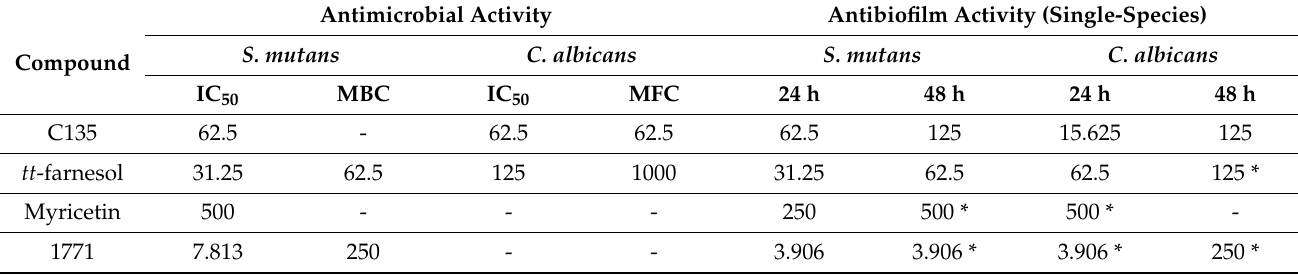
* represent selected concentrations that did not reduce 50% of CFU/mL but had a significative statistical reduction vs. vehicle between all tested concentrations. IC 50 : the inhibitory concentration of the agent that inhibited the growth of the microorganism by 50%, considering microbial growth as the CFU/mL counts. MBC: minimum bactericidal concentration. MFC: minimum fungicidal concentration. 24 h: 24 h-old biofilms. 48 h: 48 h-old biofilms.